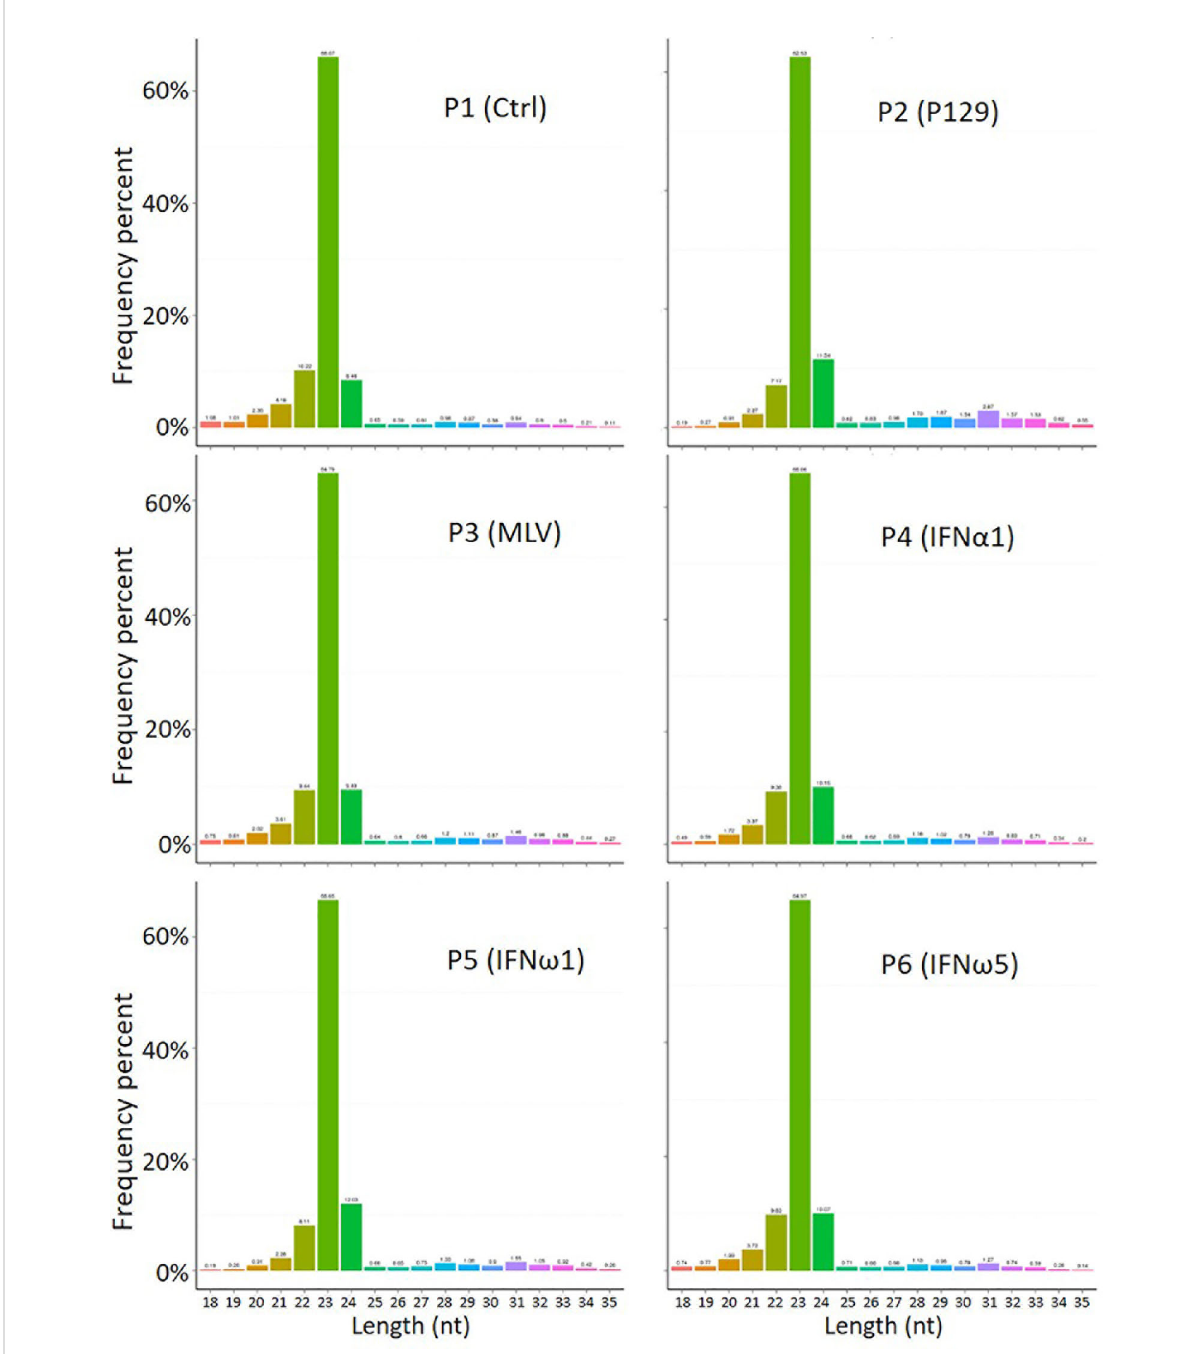
FIGURE 1 Length distribution of total sRNA pro fi led by the WTS. The abscissa is the length of sRNA reads, the ordinate is the percentage of one length read accounted for total sRNA. Shown is the majority (>80%) at 21-24 nt of typical miRNA, and comparable across the